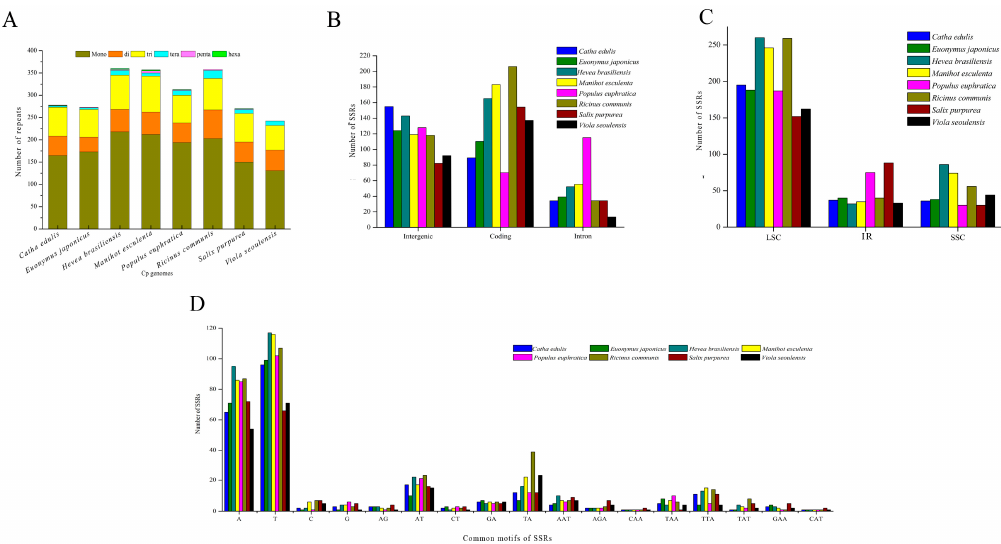
Figure 5. The distribution, type, and presence of simple sequence repeats (SSRs) in eight chloroplast genomes: ( A ) number of different SSR types detected in eight chloroplast genomes presence of SSRs at the LSC, SSC, and IR regions.; ( B ) frequency of SSRs in the protein-coding regions, intergenic spacers and intronic regions; ( C ) frequency of SSRs in the LSC, SSC, and IR regions; and ( D ) frequency of common motifs in the eight chloroplast genomes.